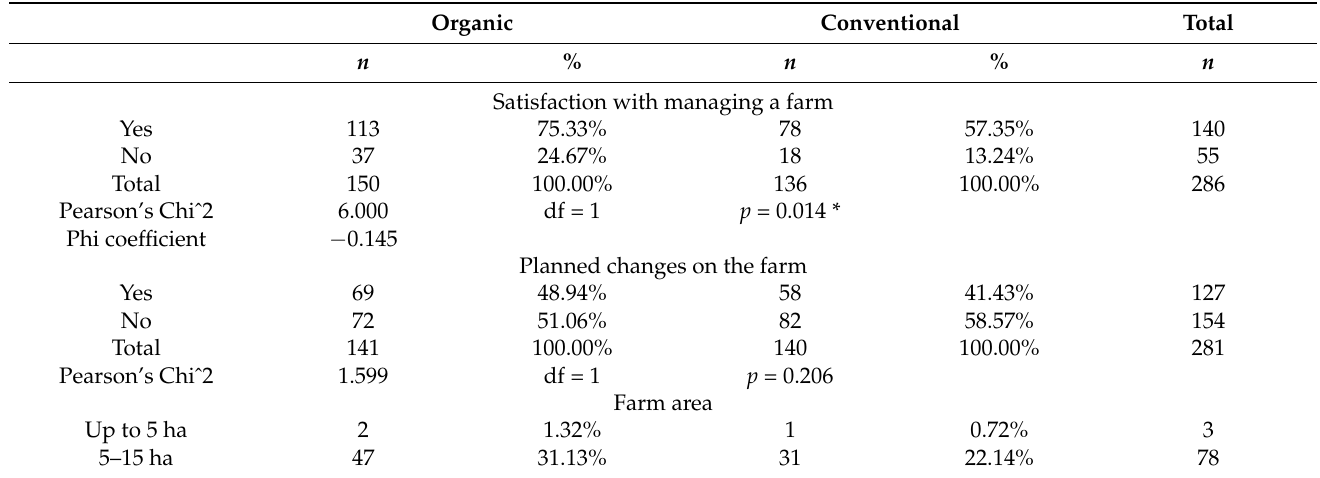
Table A2. Characteristics of farms’ economic